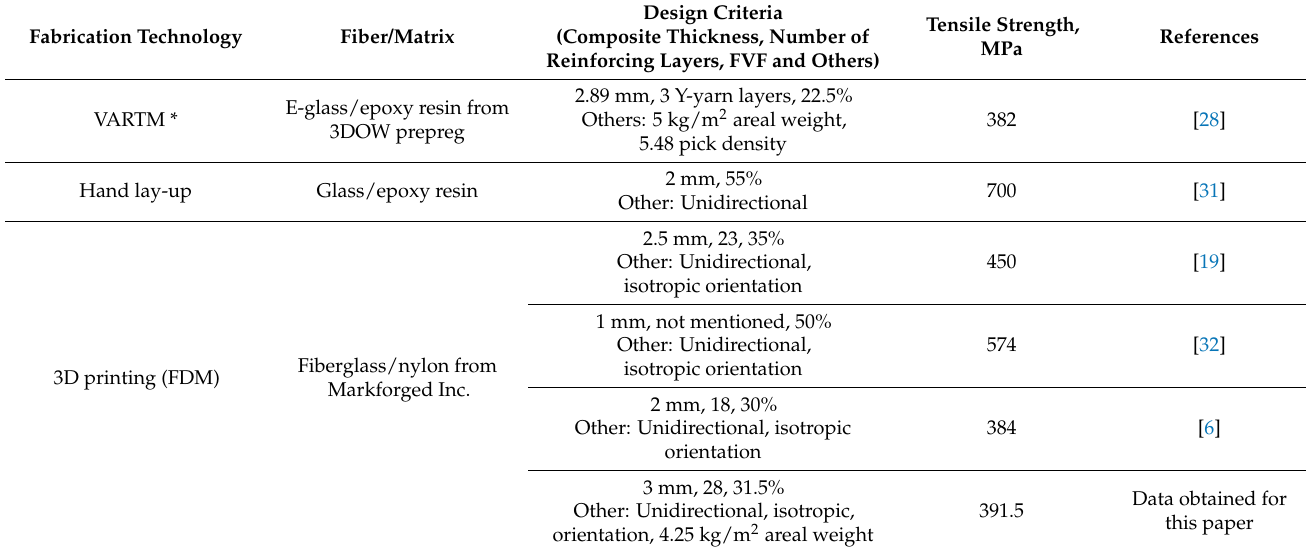
Table 2. Comparison of maximum tensile strength of different fiberglass-reinforced composites fabricated by 3D printing and traditional